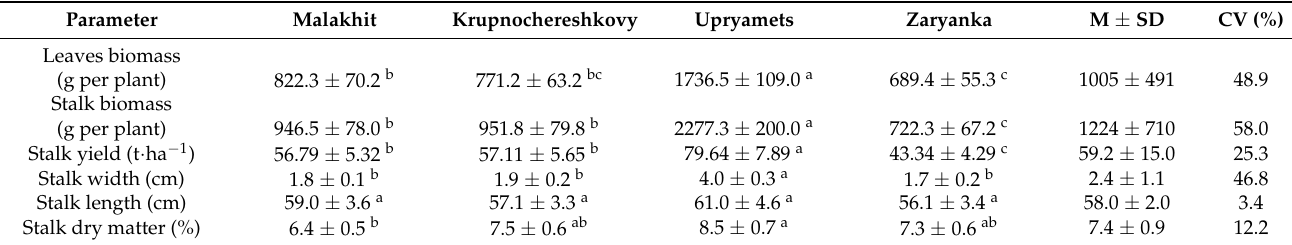
Table 1. Yield and biometric parameters of four rhubarb cultivars.